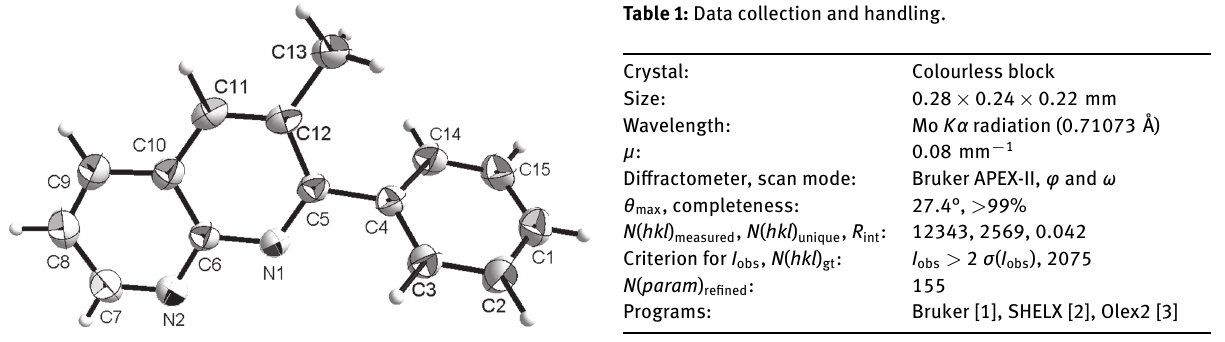
Table 2: Fractional atomic coordinates and isotropic or equivalent isotropic displacement parameters (Å 2